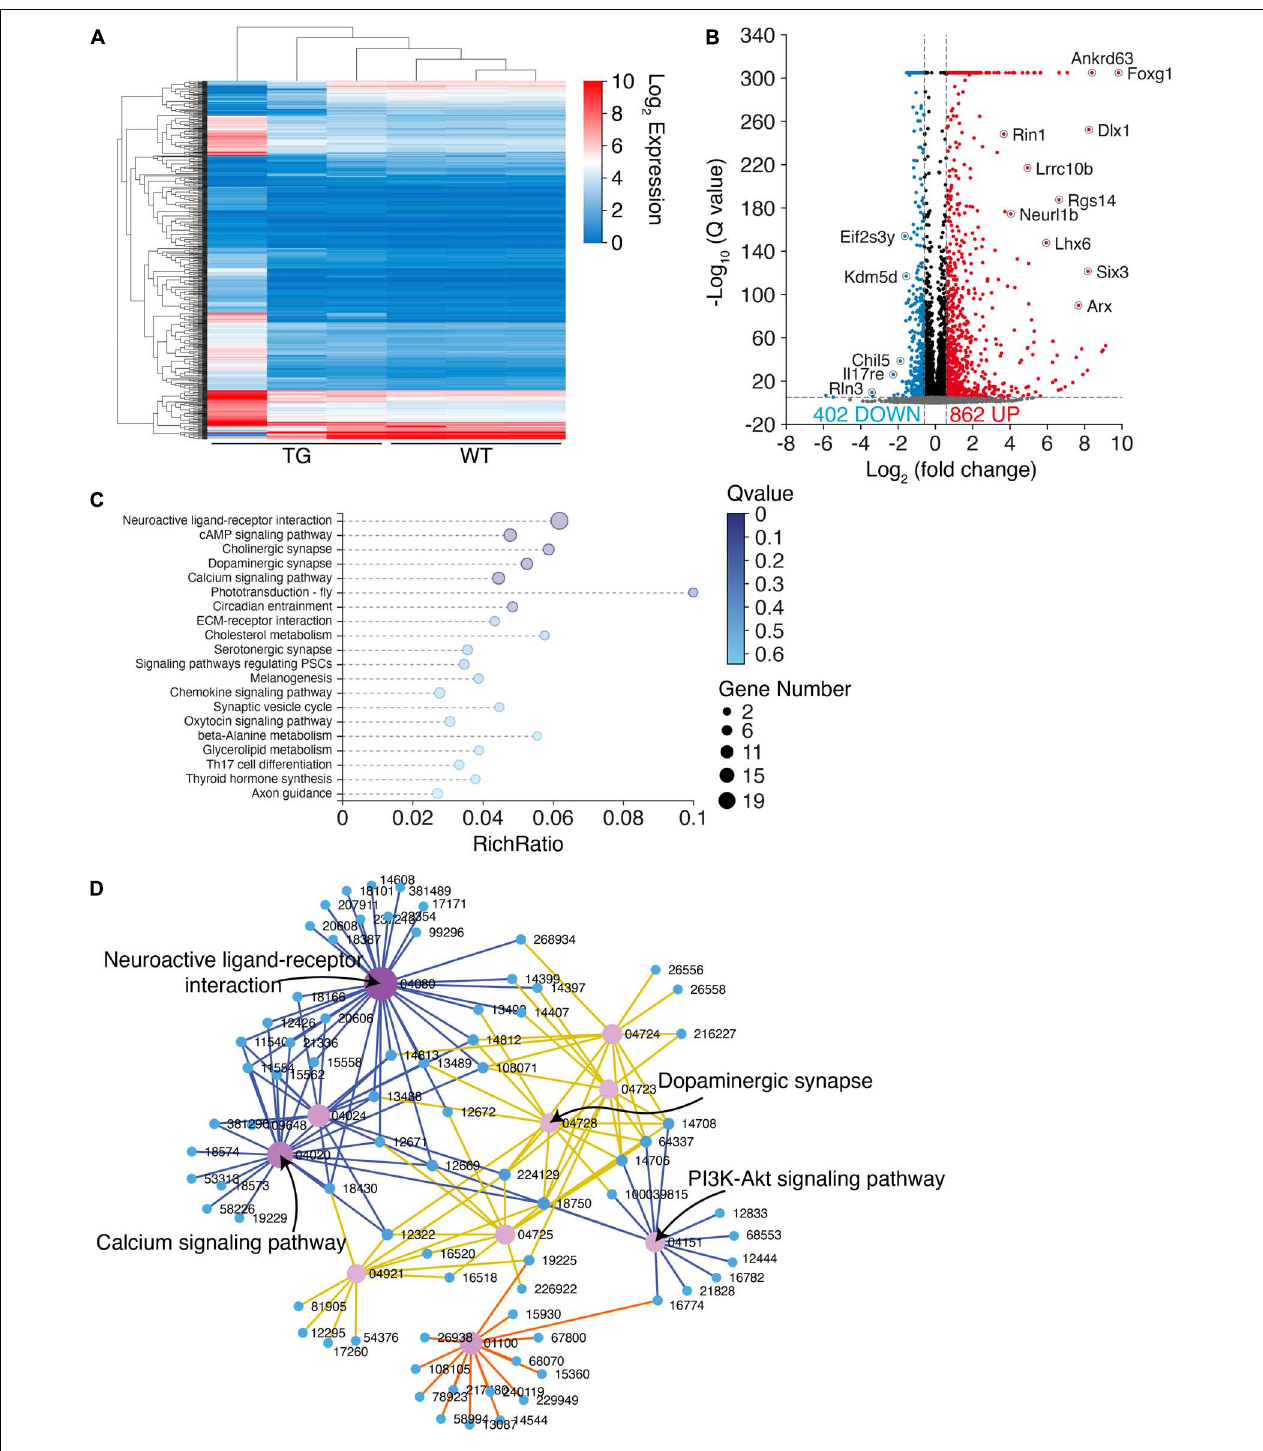
FIGURE 6 | RNA-sequencing illustrates an extensive transcriptome change in N103 mice. (A) Clustering heat map giving an overview of the altered transcriptomics of WT mice and N103 mice. n = 3 mice per group. (B) Volcano plot revealing the differentially expressed genes (DEGs) of the control group and N103 mice. Downregulated DEGs (blue) and upregulated DEGs (red) were filtered out by a threshold set as –log 10 Q value > 5 and | fold change (FC)| > 1.5. Most significant genes were annotated. (C) Enrichment analysis displaying a list of KEGG pathway terms gathering most DEGs. (D) KEGG interaction network illustrating the relationship among the most significant DEGs ranked by the Q